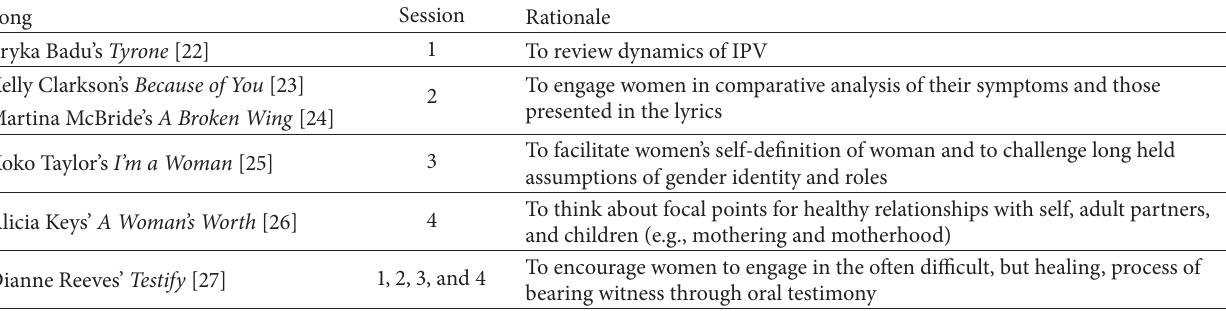
Table 1: Song selection for MAMBRA